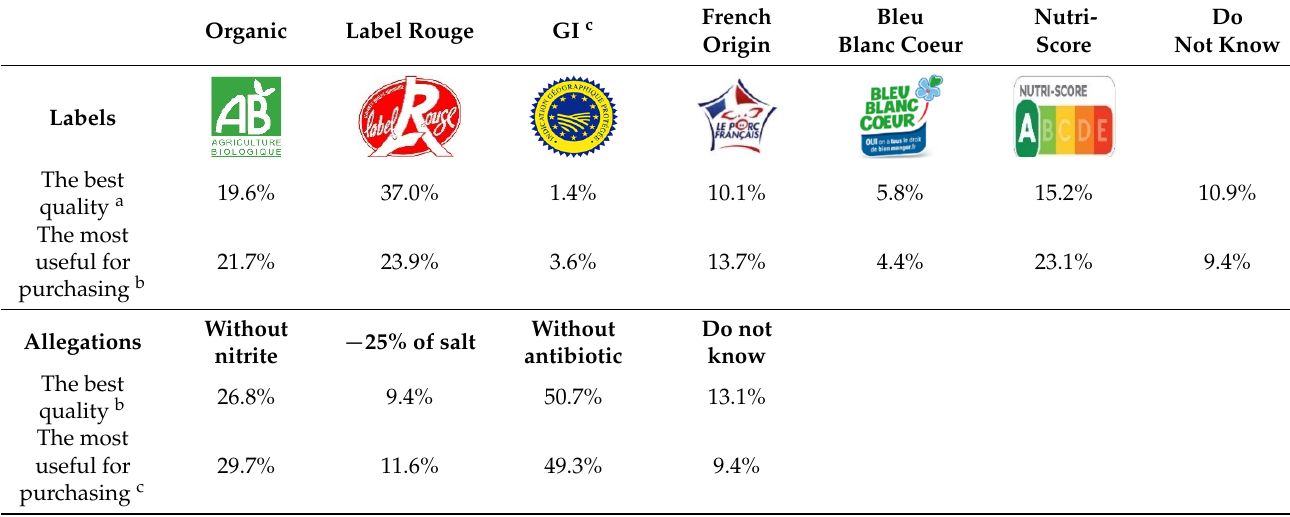
Table 4. Opinions about the main labels posted on ham packets sold in France. Labels and allegations presented to participants with their logo in the exit questionnaire (% of respondents).